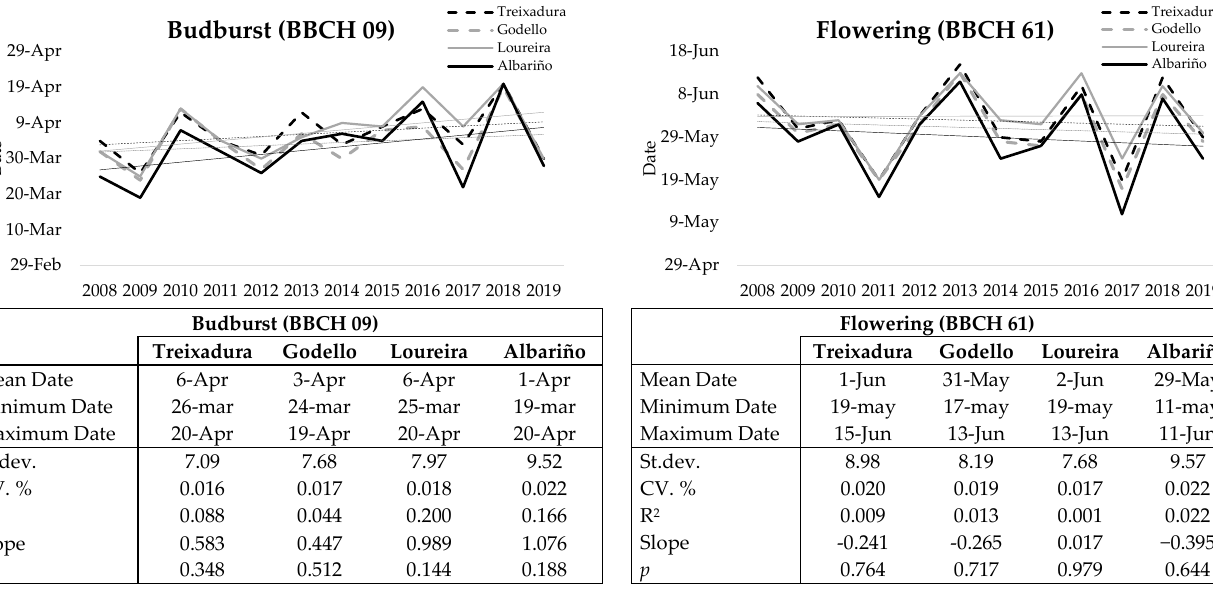
Figure 1. Phenological dates of budburst and flowering of the 4 cultivars (Treixadura, Godello, Loureira and Albariño) during 2008–2019 (Figures). Average, maximum and minimum budburst and flowering start date, standard deviation and standard deviation in percentage (Tables).